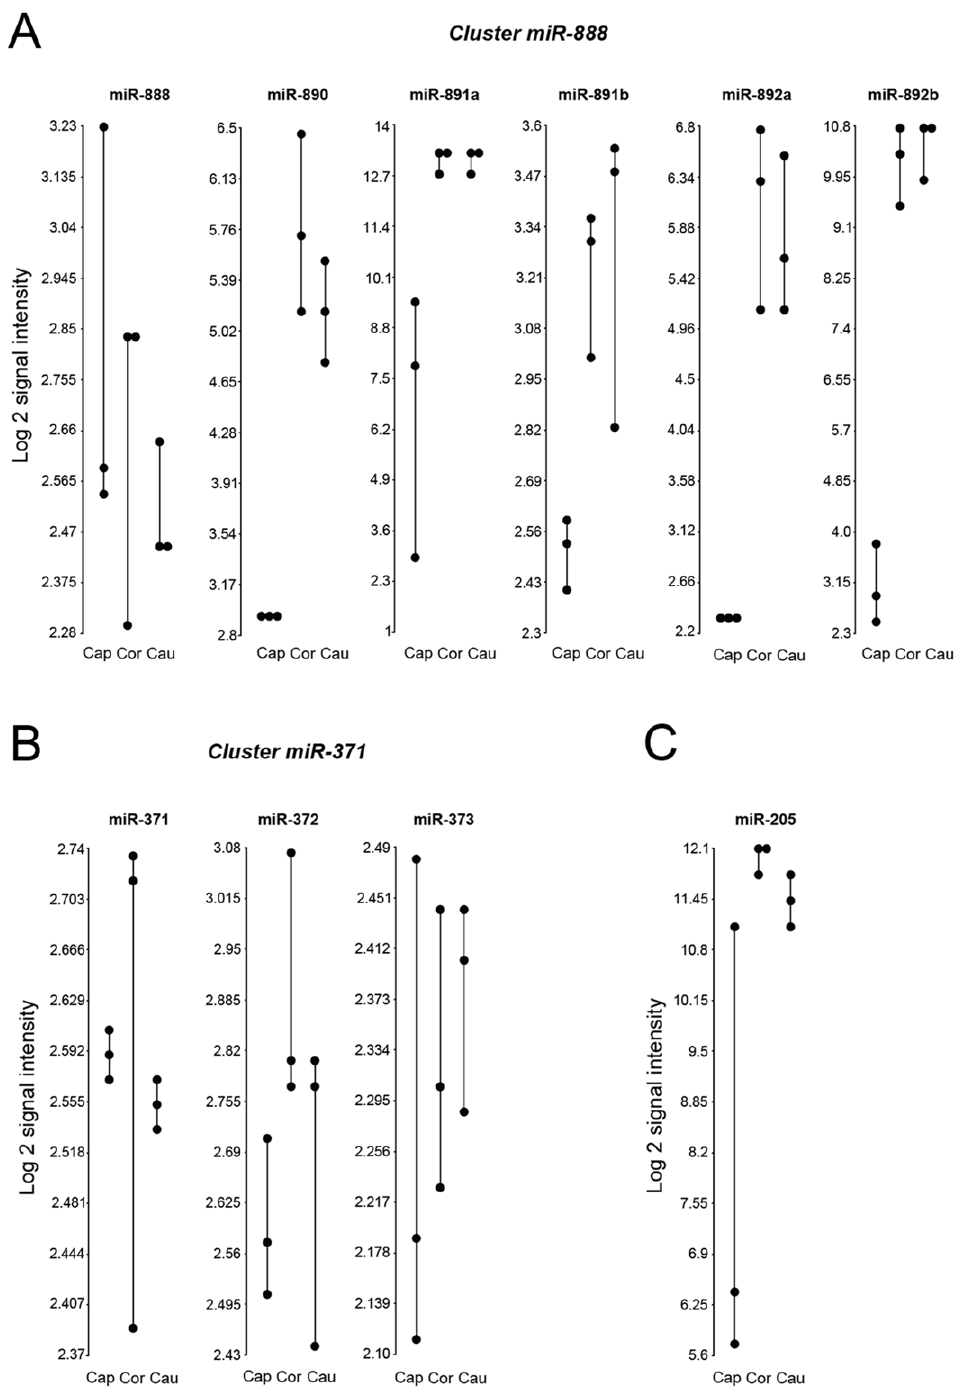
Figure 3. mir-205 and members of the miR-888 cluster are differentially expressed in the epididymal tubule. (A) (B) and (C): Dot plots showing the Log 2 signal intensity of miRNAs belonging to the miR-888 and miR-371 cluster families, and miR-205 in the different epididymal regions: caput (cap), corpus (cor) and cauda (cau). Each dot represents the intensity of a selected miRNA in one sample. Different samples providing from the same anatomical regions of the 3 donors are joined by straight lines.